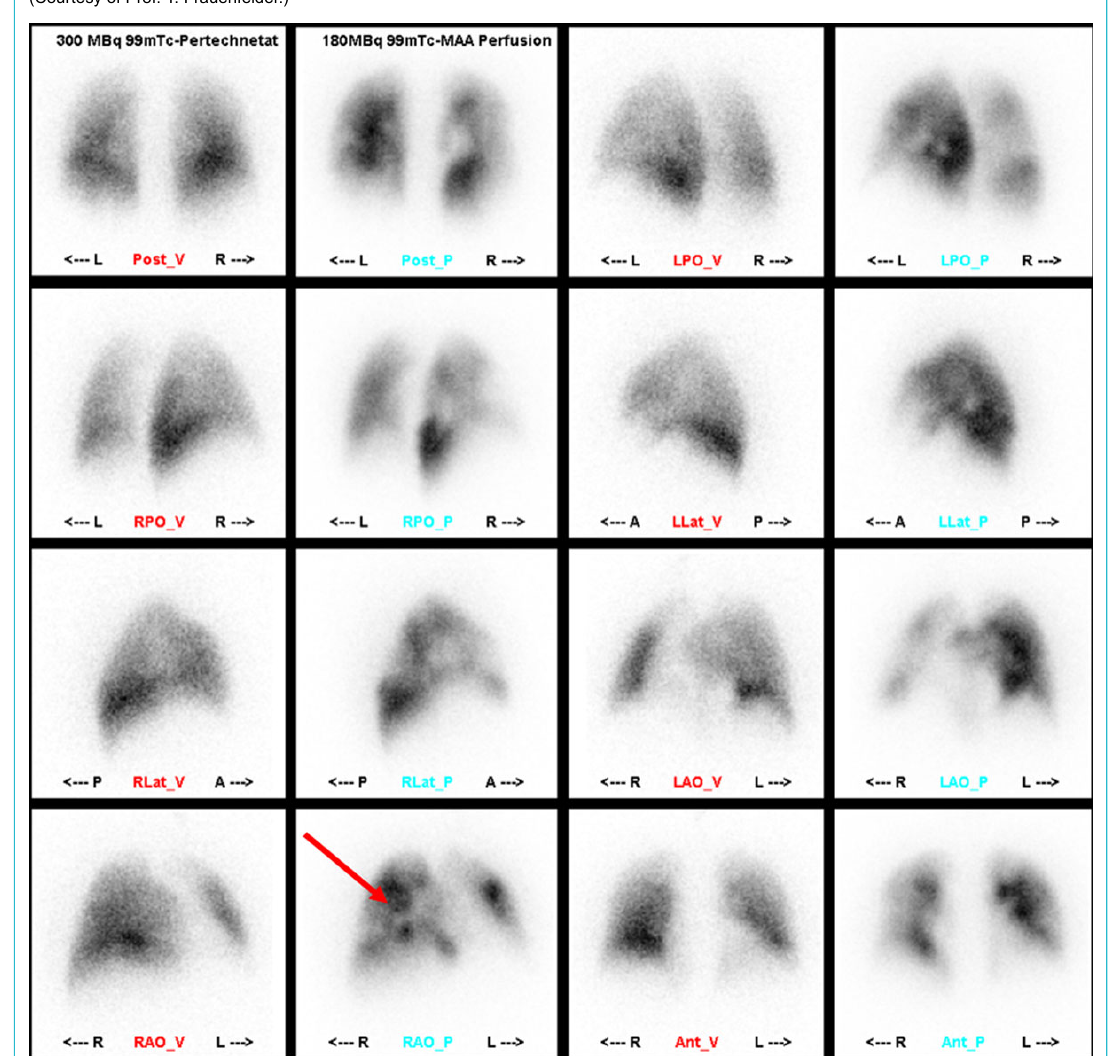
Figure 7: Ventilation/perfusion (V/Q) scan. In the perfusion images patchy perfusion defects (arrow) unmatched in the ventilation images. (Courtesy of Prof. T.